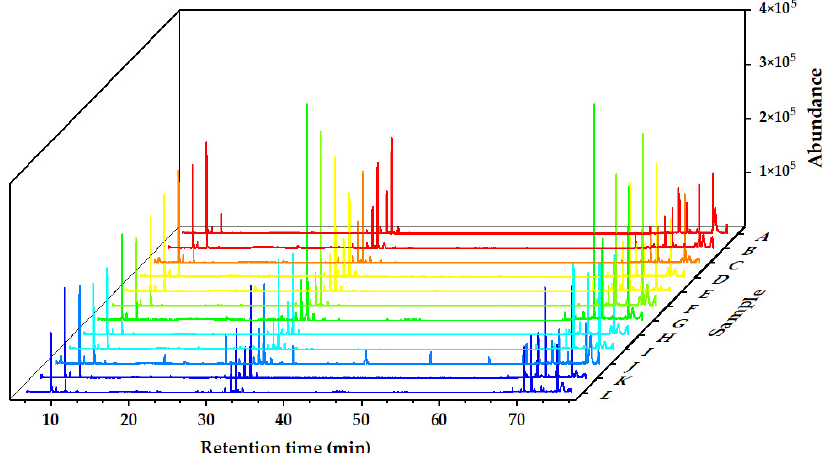
Figure 4. GC-MS chromatograms of the volatile components of the ethyl acetate extractives of Alnus cremastogyne pods.